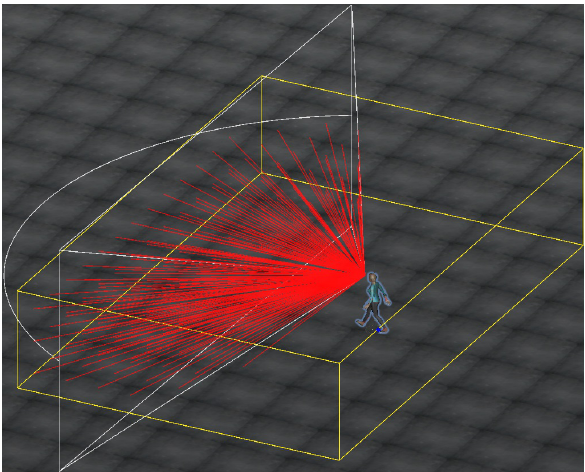
Figure 2. Visible voxels within AoI. Rays targeting visible voxels presented in red, while the area of interest is drawn in